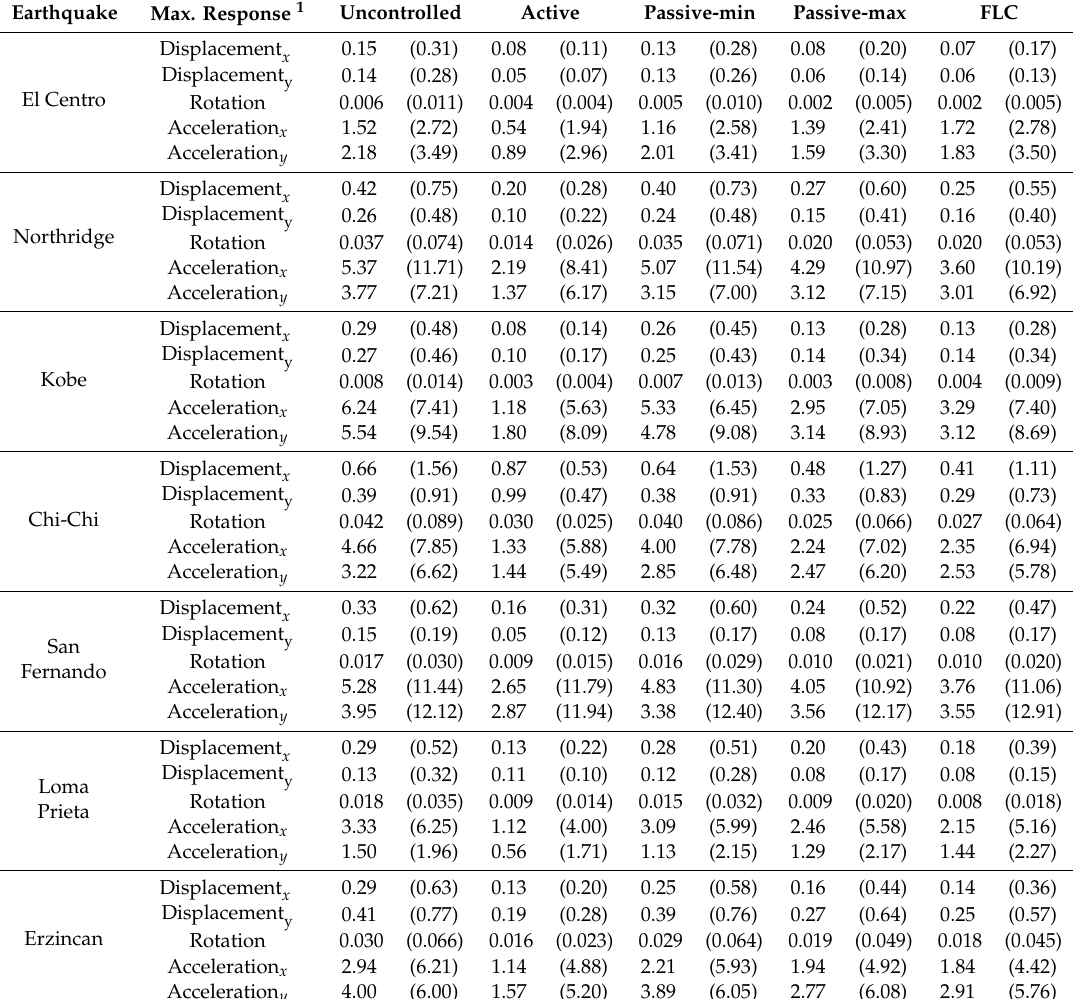
Table 4. Maximum responses of the Case-I building using di ff erent control methods considering SSI e ff ects (units in